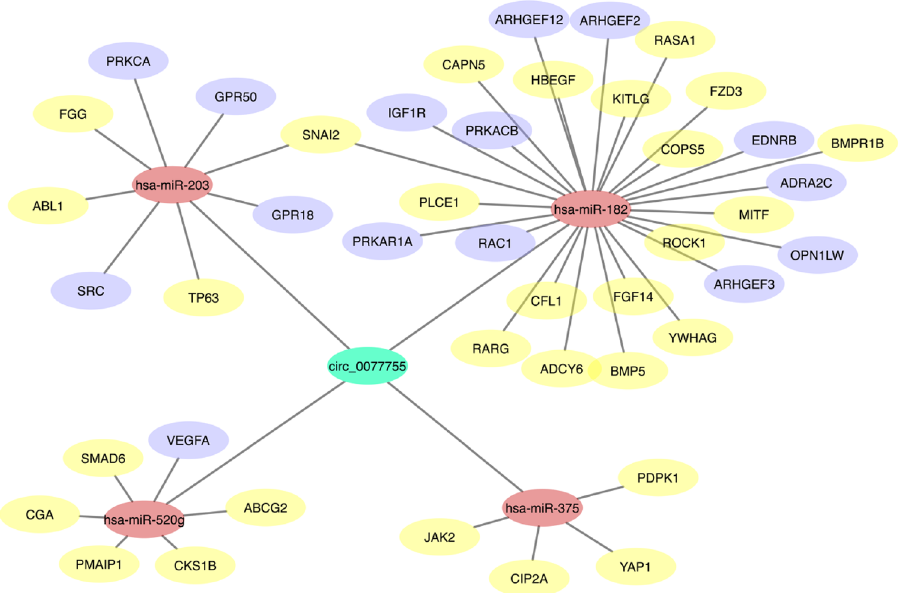
Figure 6. Gene co-expression networks shows the involvement of the validated Cx43/has_circ_0077755/miR- 182 axis in cancer-related pathways and in breast cancer. CircRNA-miRNA-mRNA gene co-expression network for hsa_circ_0077755 was predicted by TargetScan 65 within IPA and Cytoscape was used to draw circRNA- miRNA-mRNA interaction networks. CircRNA is colored in green, miRNAs in pink and mRNAs reported in cancer in yellow and in breast cancer in purple. miR-182 exhibited the largest interaction network with mRNAs involved in cancer-related pathways in the